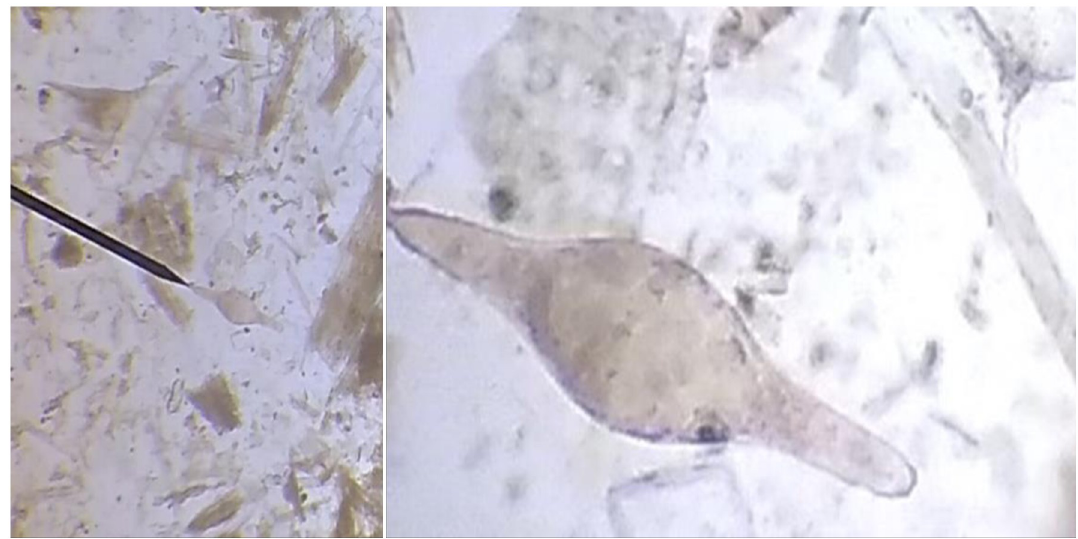
Fig 1. Identified Schistosoma bovis egg using stereomicroscope.